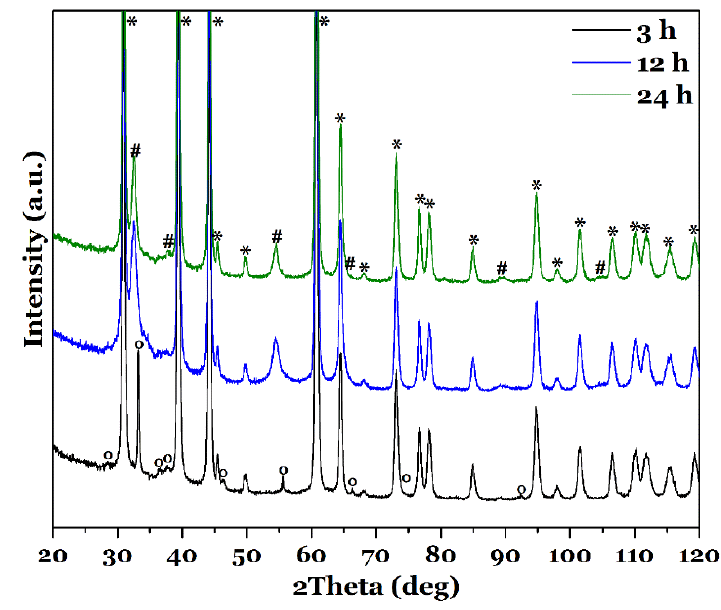
Figure 2. XRD pattern of CuInS 2 films synthesized with L -cysteine for different reaction times, 3, 12 and 24 h, at 150 °C. Signals stemming from FTO are marked with *, the ones originating from CuInS 2 with #, reflections from CuCl with °. The ° reflections could also stem from InS.